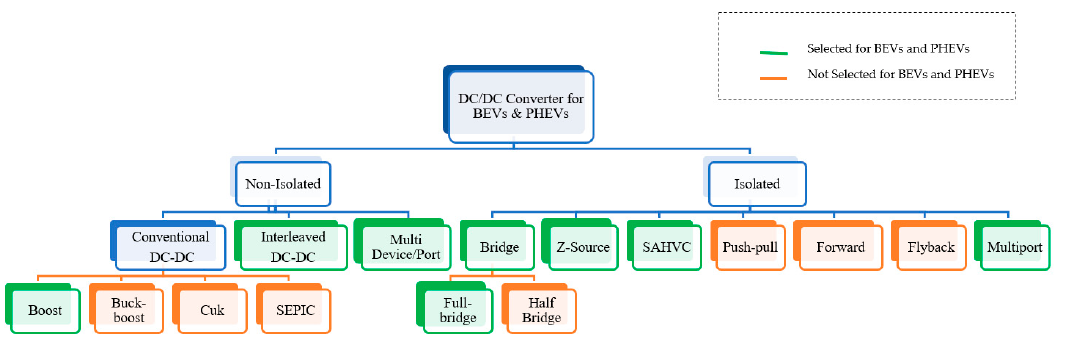
Figure 5. Classification of DC-DC converter F igure 5. Classification of DC-DC converter topologies.